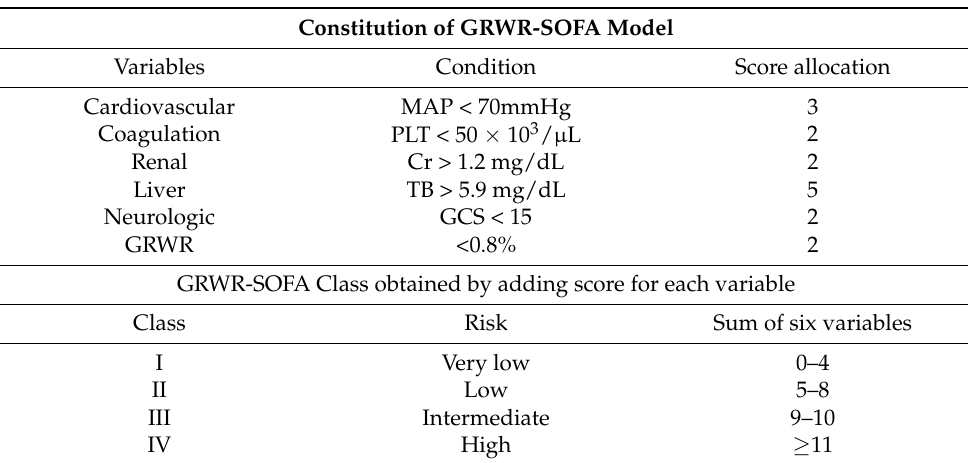
Table 4. Constitution and risk classification of GRWR-SOFA